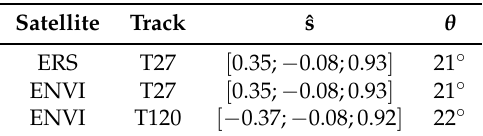
Table 1. Unit vector ˆ s = [ s E , s N , s U ] pointing from a point on the ground to the sensor aboard the satellite and satellite incidence angle θ for European Remote-Sensing (ERS) track 27 and Envisat tracks 27 and